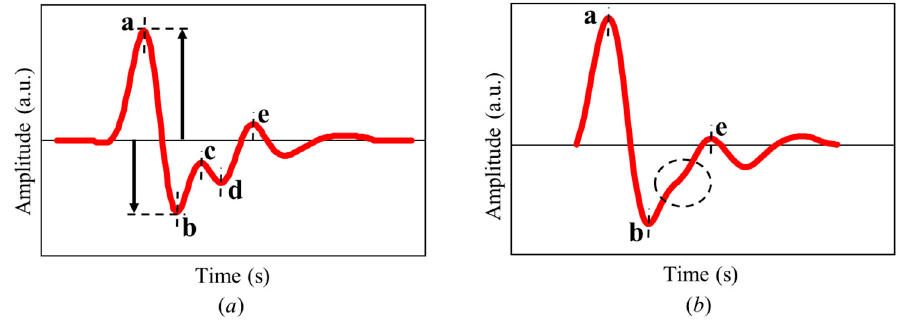
Figure 2. Examples of a second derivative photoplethysmography (SDPPG) waveform: ( a ) a typical SDPPG waveform with five peaks and ( b ) an SDPPG waveform missing waves c and d.